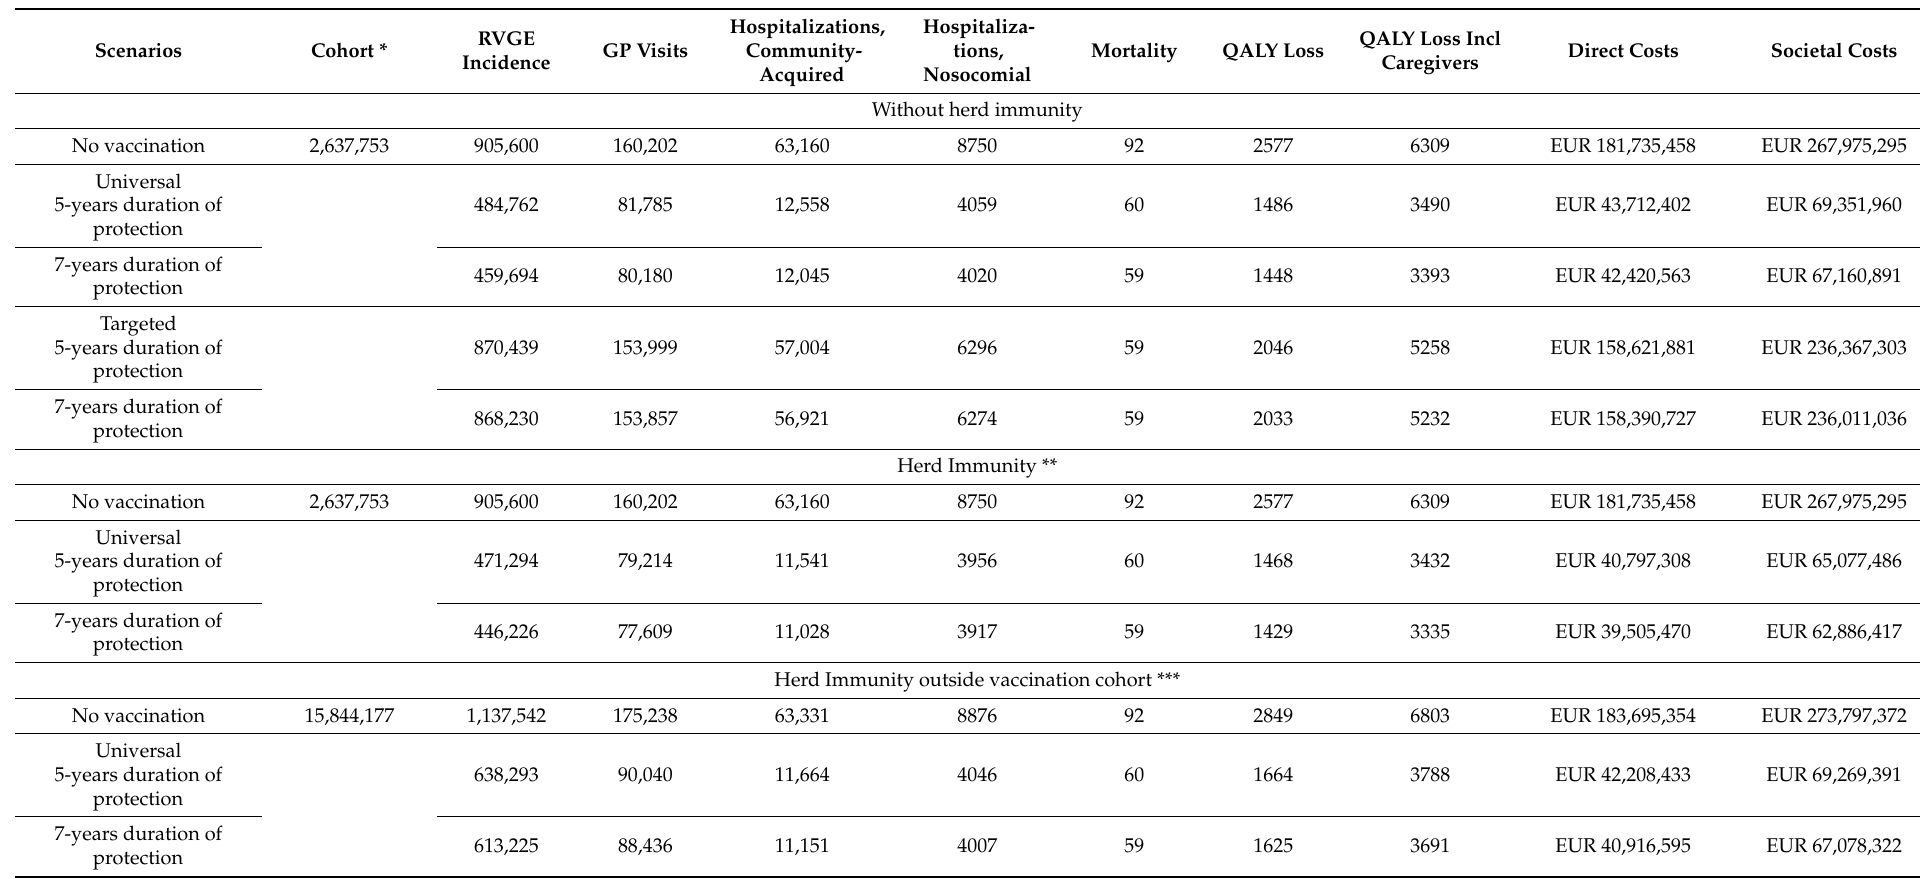
Table 7. Cohort- and time-horizon-dependent rotavirus incidence, general practitioner (GP) visits, hospitalizations, and mortality for universal, targeted, and no vaccination across different vaccine effectiveness